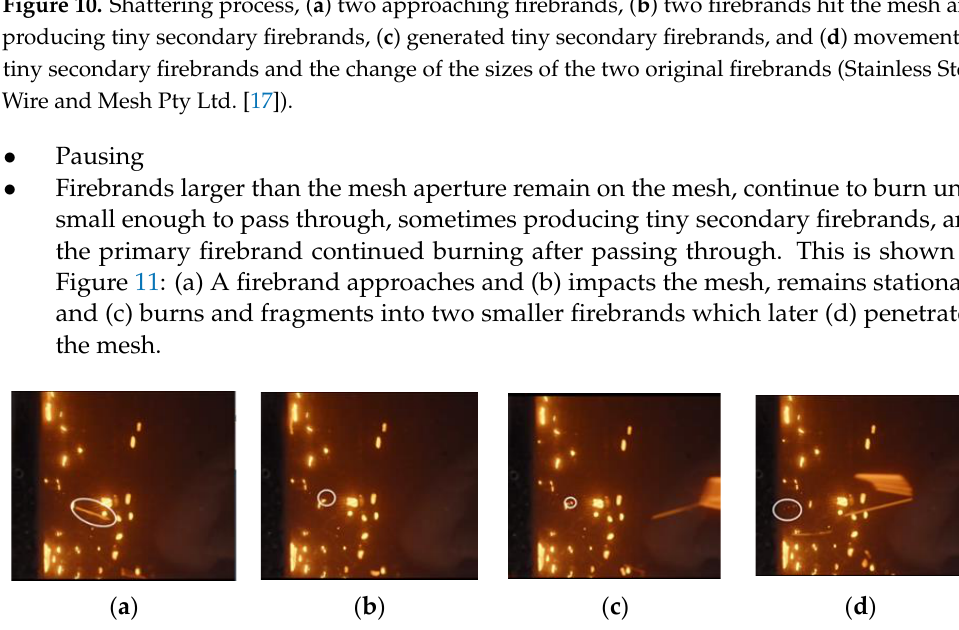
( f ) Figure 13. Firebrands bounce back after hitting the mesh. The encircled firebrands ( a ) impact the mesh, ( b ) bounce back, ( c – e ) return to the mesh and ( f ) settle into a new position and continue to burn (Stainless Steel Wire and Mesh Pty Ltd. [17]). •